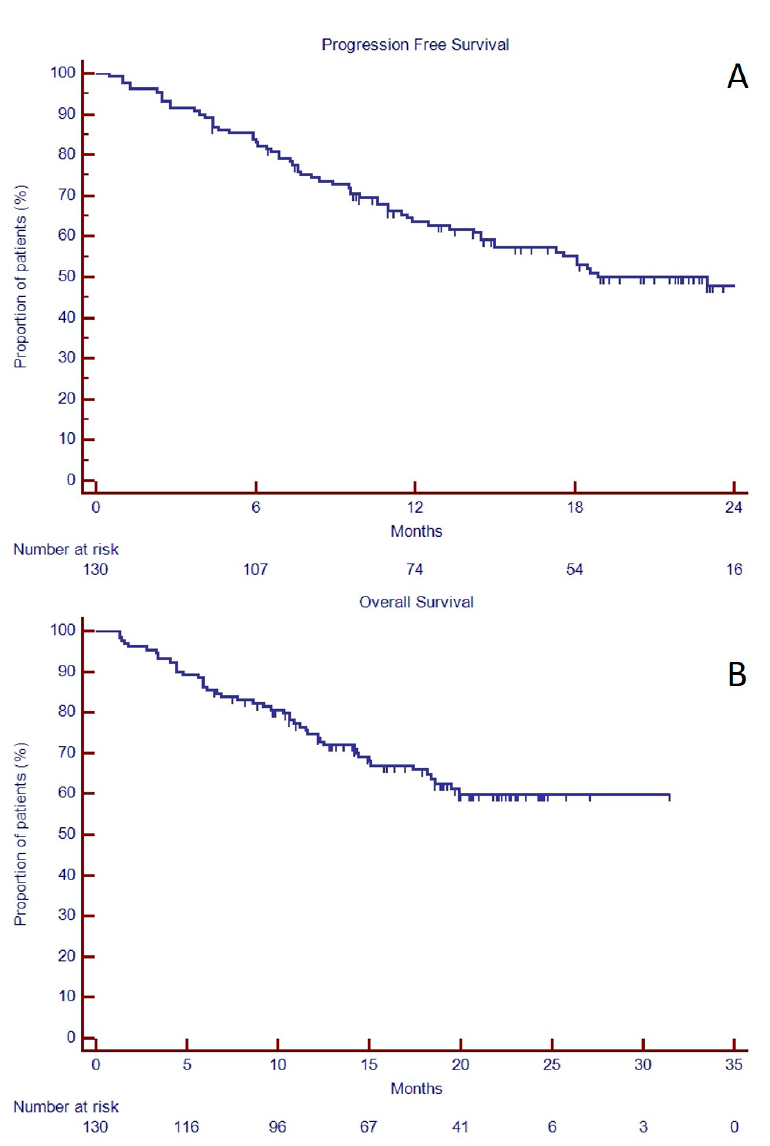
Figure 1. Progression free survival ( A ) and overall survival ( B ) in 130 relapse and refractory multiple myeloma (RRMM) candidates to KRd as salvage regimen in a real-life approach.